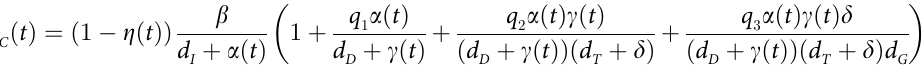
, d , I (2005), β , q 1 , q 2 ) are estimated by using I D